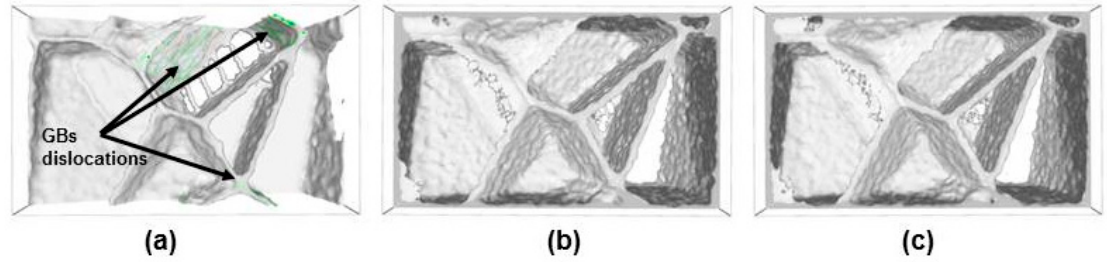
Figure 4. Nanocrystalline samples obtained after annealing at 300 K for 100 ps. ( a ) Fe, ( b ) Fe-C, and ( c ) Fe-N. Atoms are omitted for better visualization.